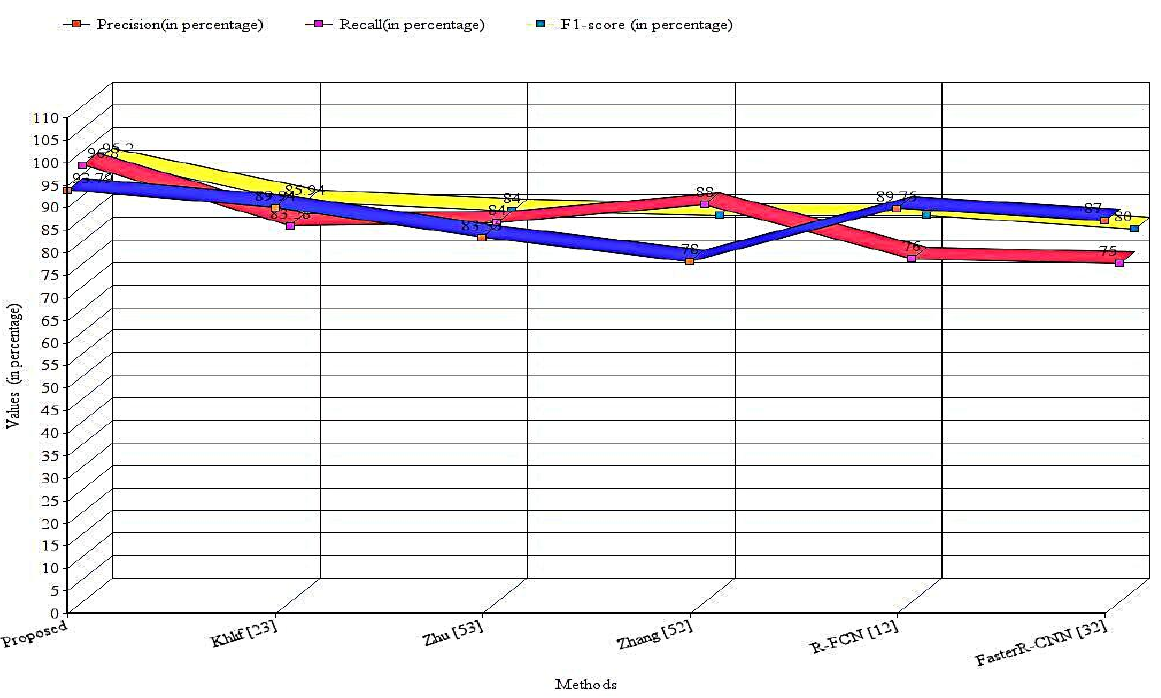
Figure 12. The comparative analysis Precision, Recall and